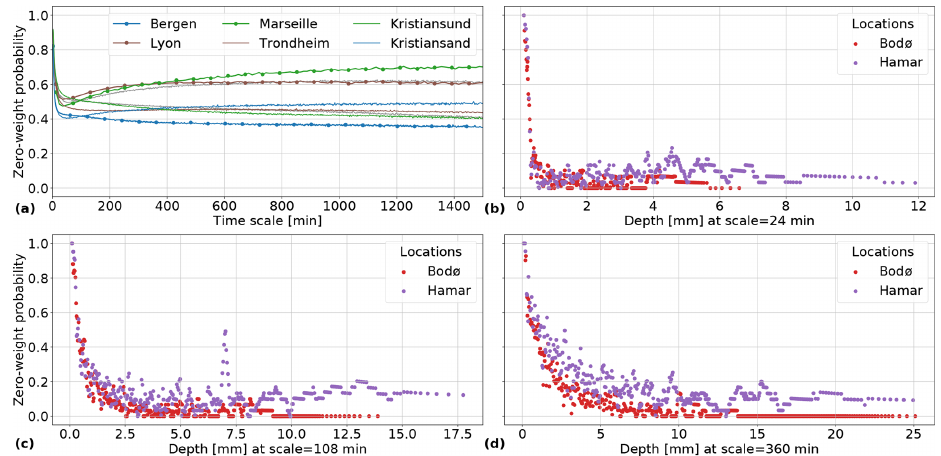
Figure B1. Zero-weight probability depending on timescale for Bergen, Lyon, Marseille, Trondheim, Kristiansund and Kristiansand (a) . Zero-weight probability depending on the rainfall depth for different timescale: 24min (b) , 108min (c) and 360min (d) for Bodø and Hamar.